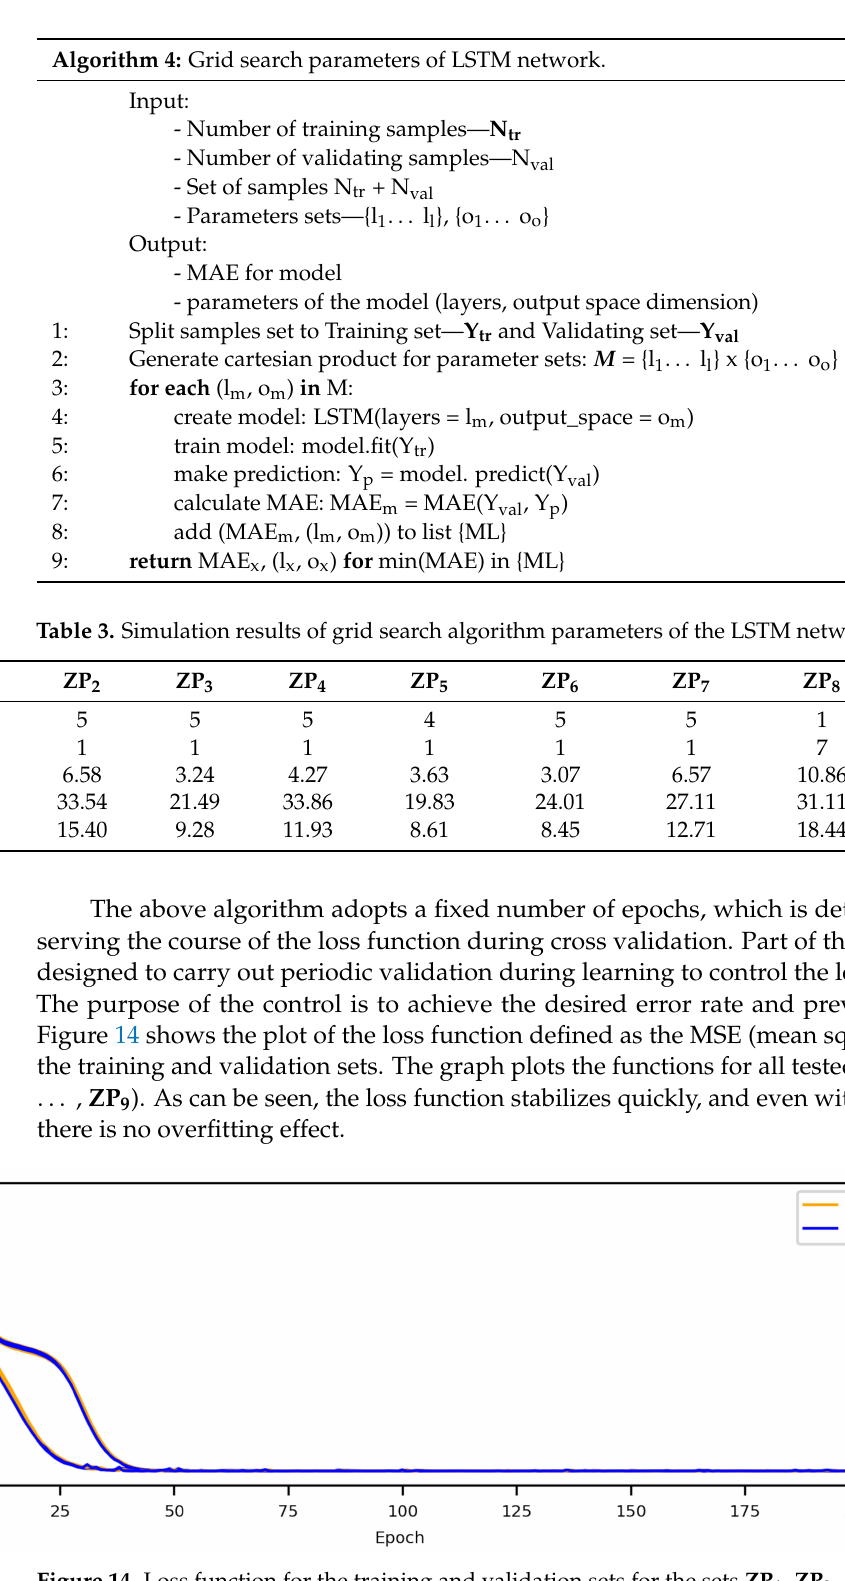
Figure 14. Loss function for the training and validation sets for the sets ZP 1 , ZP 2 , . . . , ZP 9